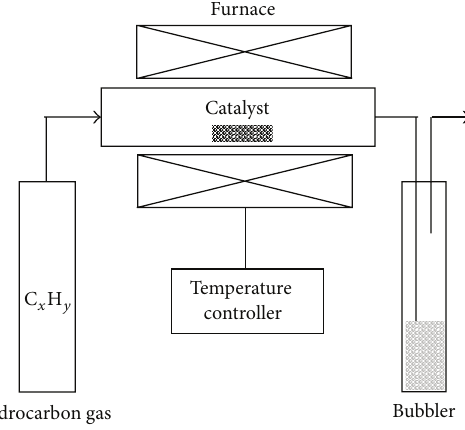
Figure 17: Schematic diagram of a simple CVD setup